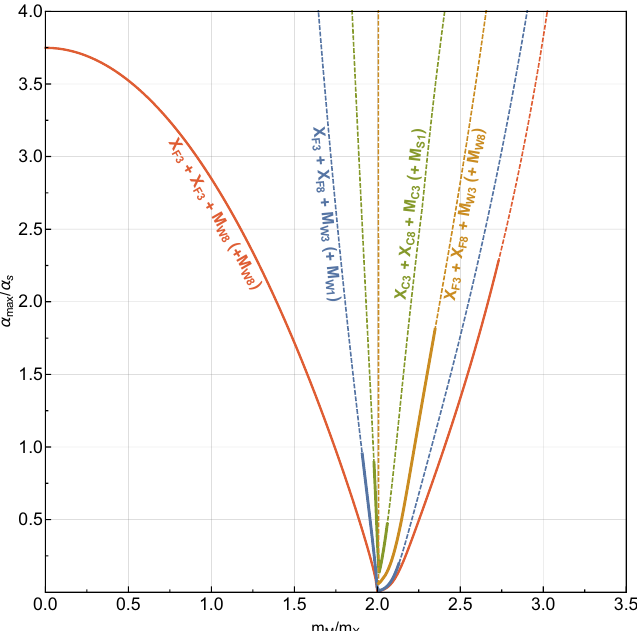
Figure 6 . ~ R = 1 contours in the ( (cid:11) max ; m M ) plane, with ~ R de(cid:12)ned in equation (3.11). The thick m X solid lines show the regions for which the width of the mediators are smaller than 25% of their mass. The particle content of each model is shown as a label next to the corresponding line and is of the form X 1 + X 2 + M 2-partner (+ M 1-partner ) where M 2-partner and M 1-partner are the mediators of the two-partner and one-partner models respectively. For the X F3 + X F3 + M W8 (+ M W8 ) model, the two-partner mediator mediates both the mixed and self annihilation of the X i